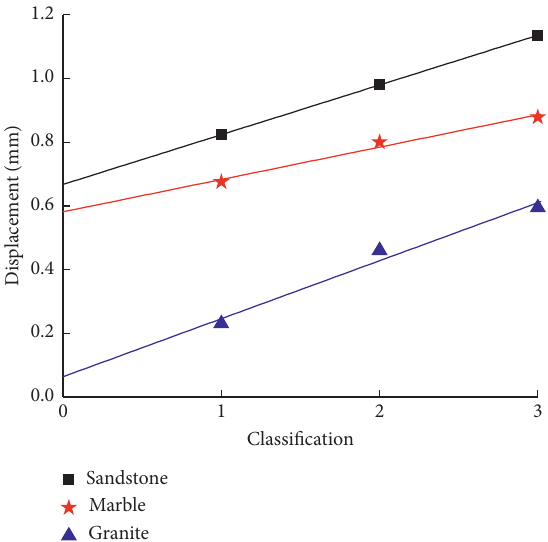
Figure 5: Fitting curve of creep at different